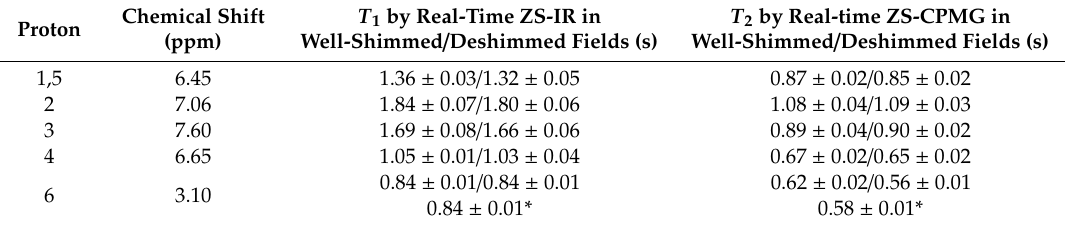
Figure 3. Relaxation measurements for the quinine sample. The molecular structure of quinine with the assigned proton is given at the top. ( A ) Conventional 1D NMR spectrum of the quinine sample in the well-shimmed field. ( B ) 1D pure shift spectrum obtained by the real-time ZS-IR / CPMG in the well-shimmed field. ( C ) Conventional 1D NMR spectrum in the deshimmed field. ( D ) 1D pure shift spectrum by the real-time ZS-IR / CPMG in the deshimmed field. Table 1. T 2 relation values and errors of some typical peaks by real-time ZS-IR / CPMG and conventional IR /